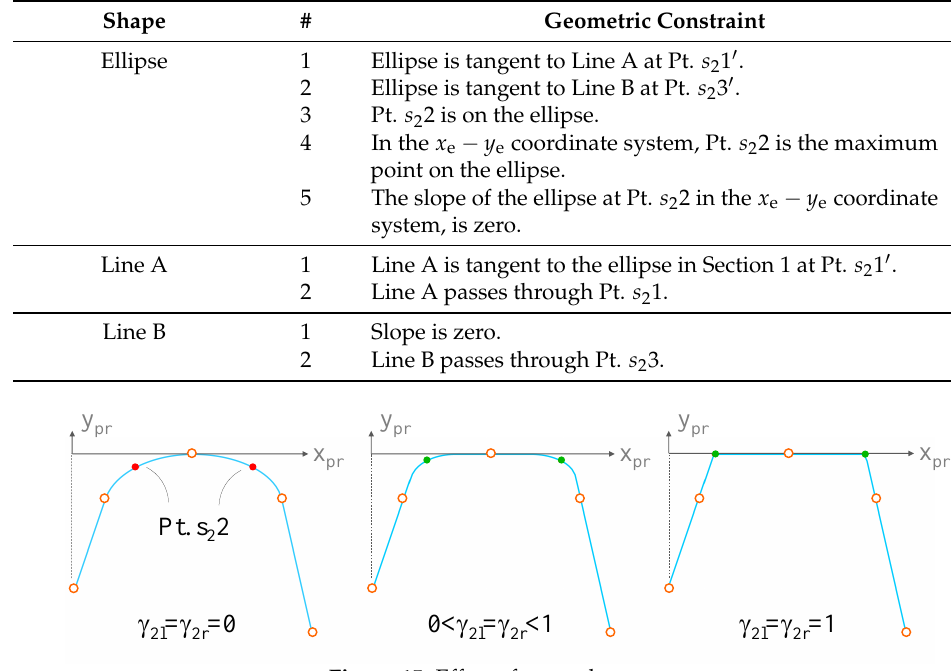
Figure 15. Effect of γ 2l and γ 2r